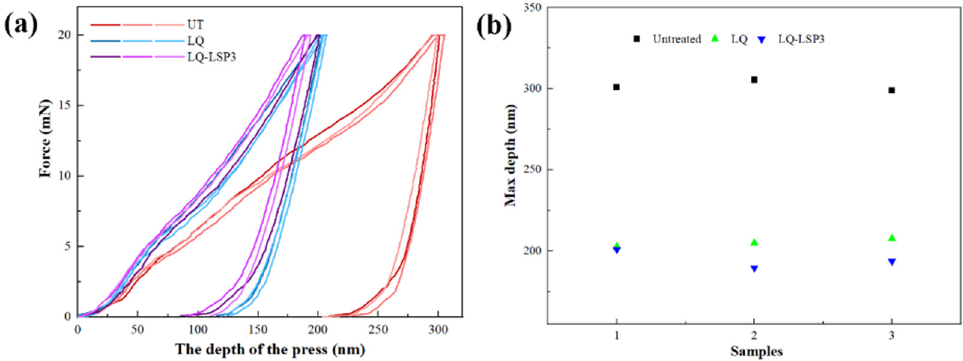
Figure 10. Nanoindentation load–depth curves and the maximum nanoindentation depth of specimens after different processes. ( a ) Nanoindentation load–depth curves; ( b ) maximum nanoindentation depth .